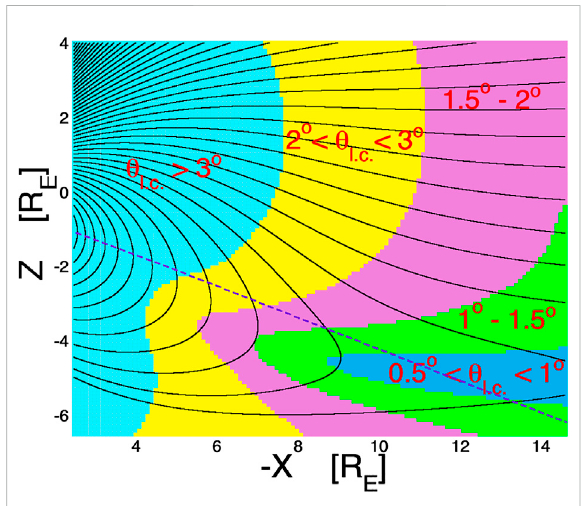
FIGURE 1 The half-angle of the atmospheric loss cone θ l.c. Is plotted in color. In the light-blue shaded region θ l.c. > 3 ° , in the yellow region 2 ° < θ l.c < 3 ° , in the pink shaded region 1.5 ° < θ l.c < 2 ° , in the green shaded region 1 ° < θ l.c < 1.5 ° , and in the blue shaded region 0.5 ° < θ l.c < 1 °